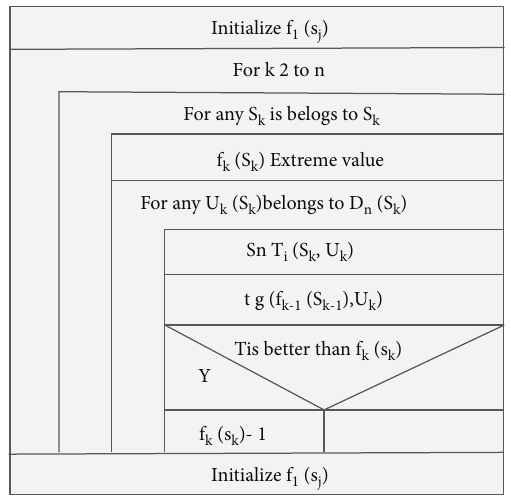
Figure 3: The basic process of solving dynamic algorithm.